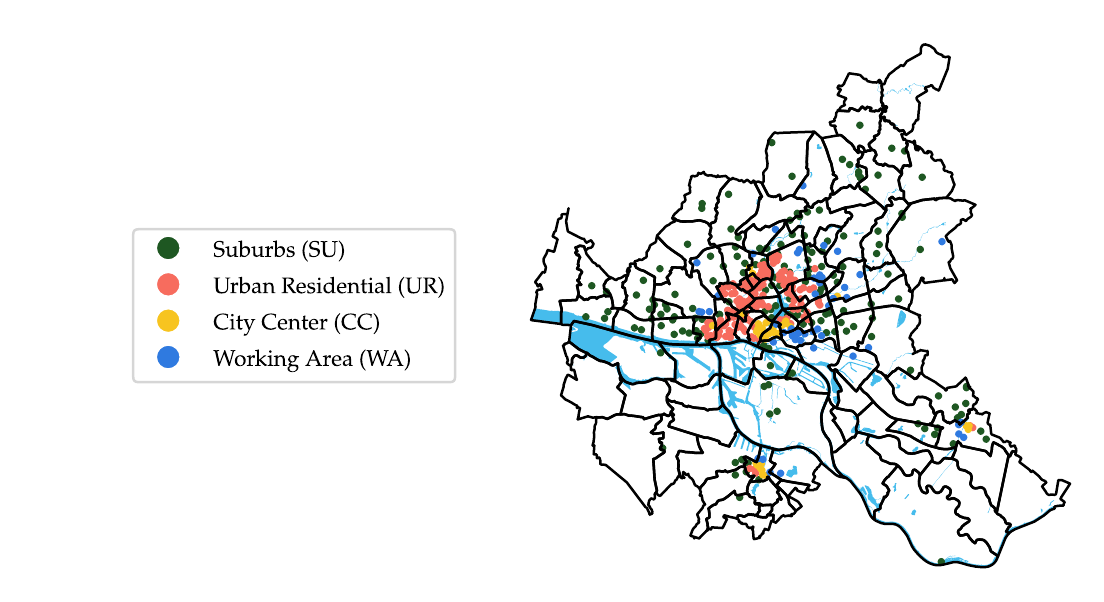
Figure 9. Clustered charging stations of the study region.